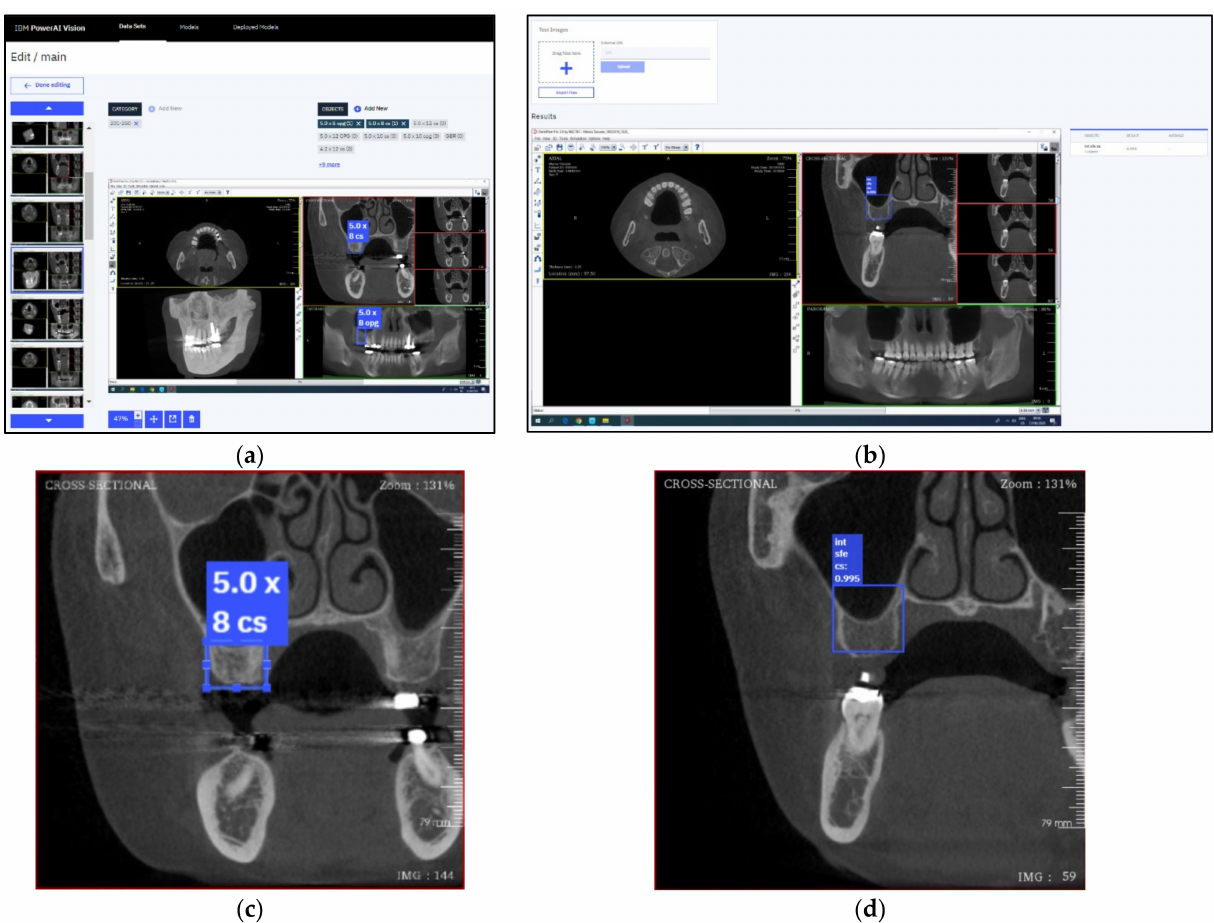
Figure 3. GUI of the IBM PowerAI Vision platform during the labelling process ( a ), during the testing process ( b ), the magnification of cross-sectional image during the labelling process ( c ), and the magnification of cross-sectional image during the testing process ( d